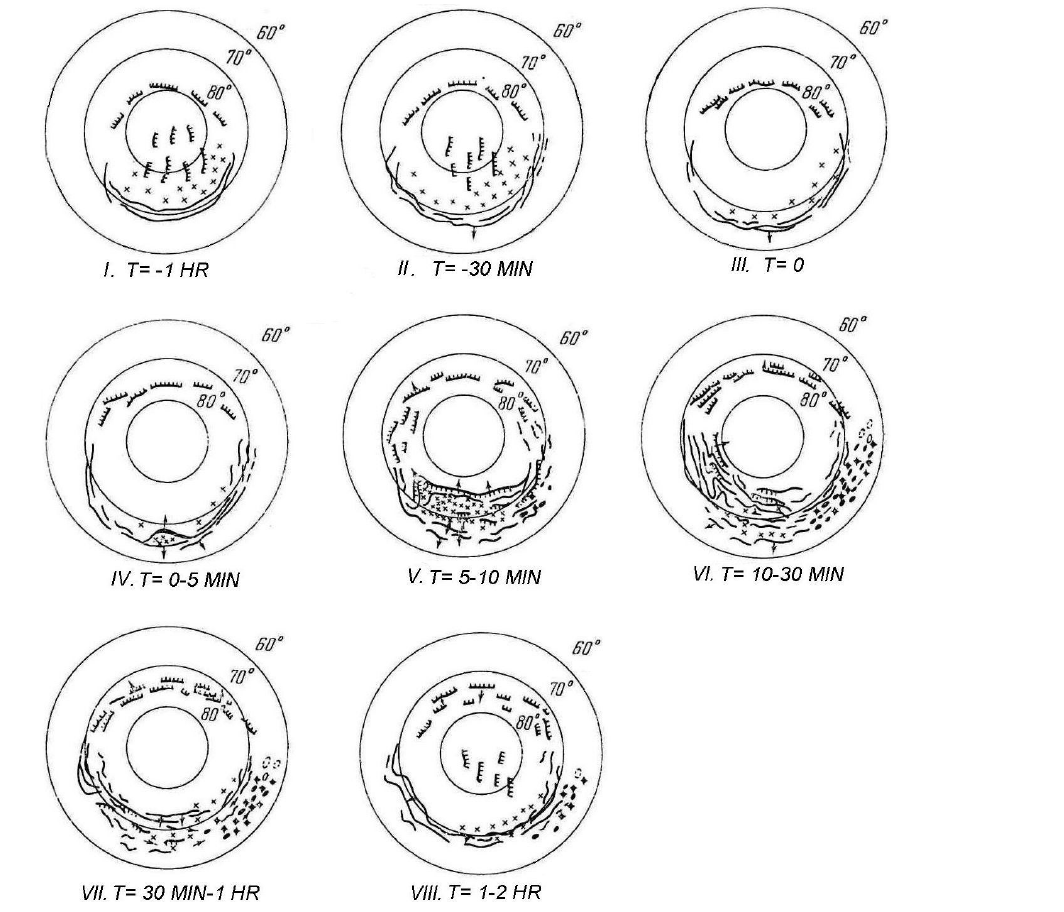
Figure 21. Planetary scheme of auroral substorm development (Feldstein and Starkov, 1970b; Starkov and Feldstein, 1971a).